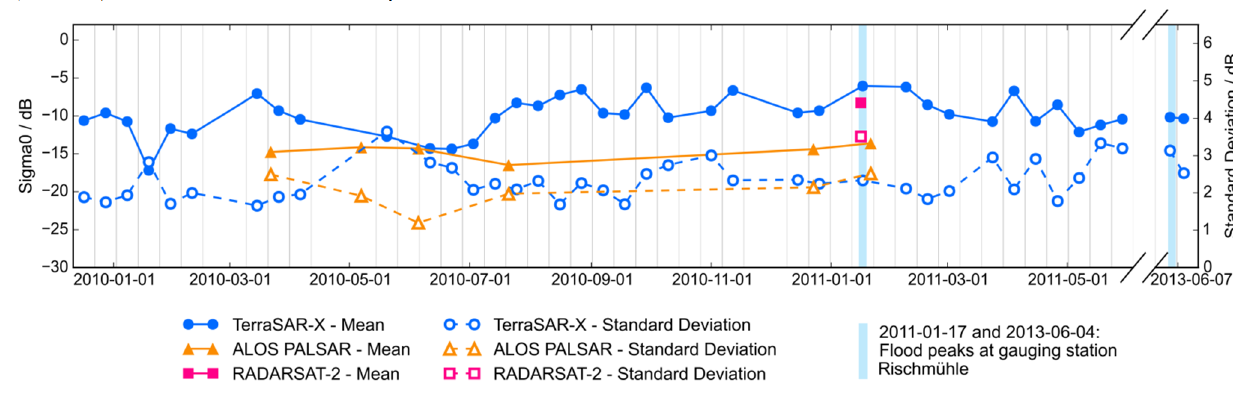
Figure 9. Time course of σ 0 (dB): Mean and standard deviation for test class 5 (Cropland, non-flooded).